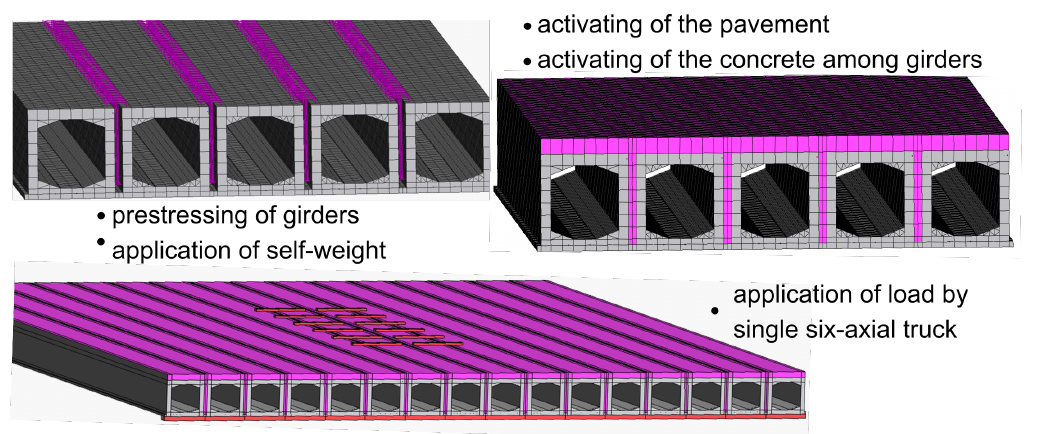
Figure 2. Three construction phases of the bridge represented by NLFEM.